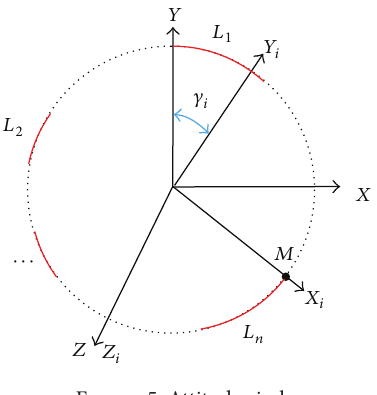
Figure 5: Attitude